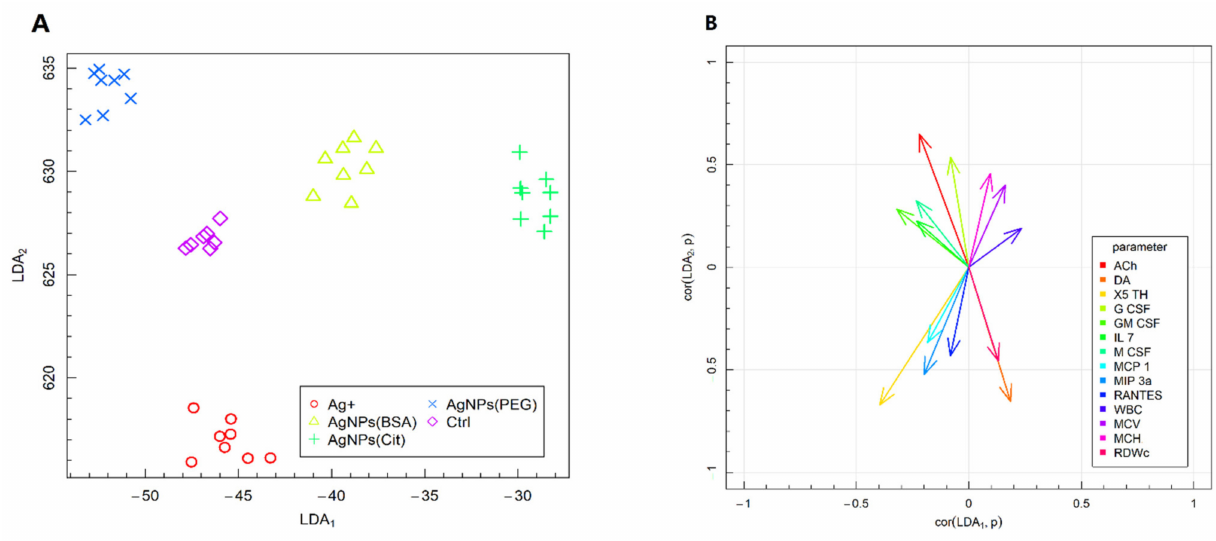
Figure 5. Fisher’s LDA: ( A )—experimental data on the plane spanned by two of the most data-separating LDAs; ( B )—parameters contributing the most to